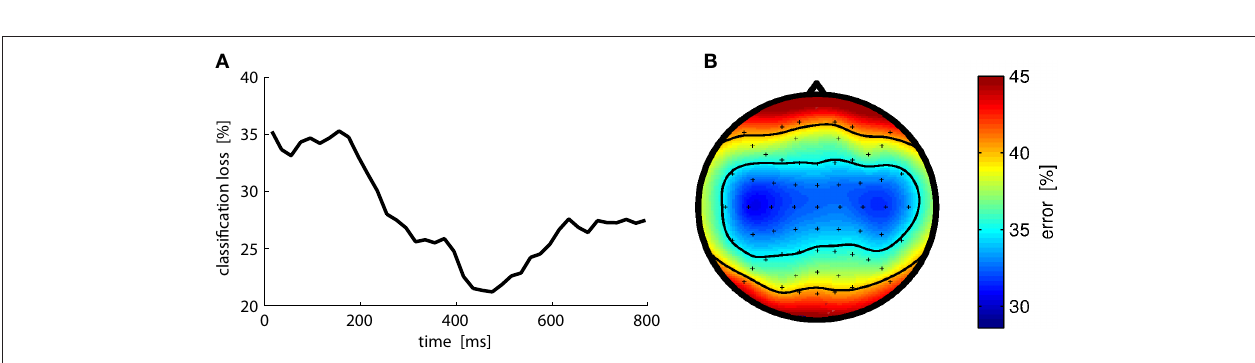
FIguRE 5 | grand average of the spatial distribution of the stimulus-specific N200 component (A) and P300 component (B). Area-under-the ROC-curve (ssAUC) values are signed such that positive values stand for a positive components and negative values represent negative components. Plots are arranged corresponding to the 3 × 3 design of the PASS2D